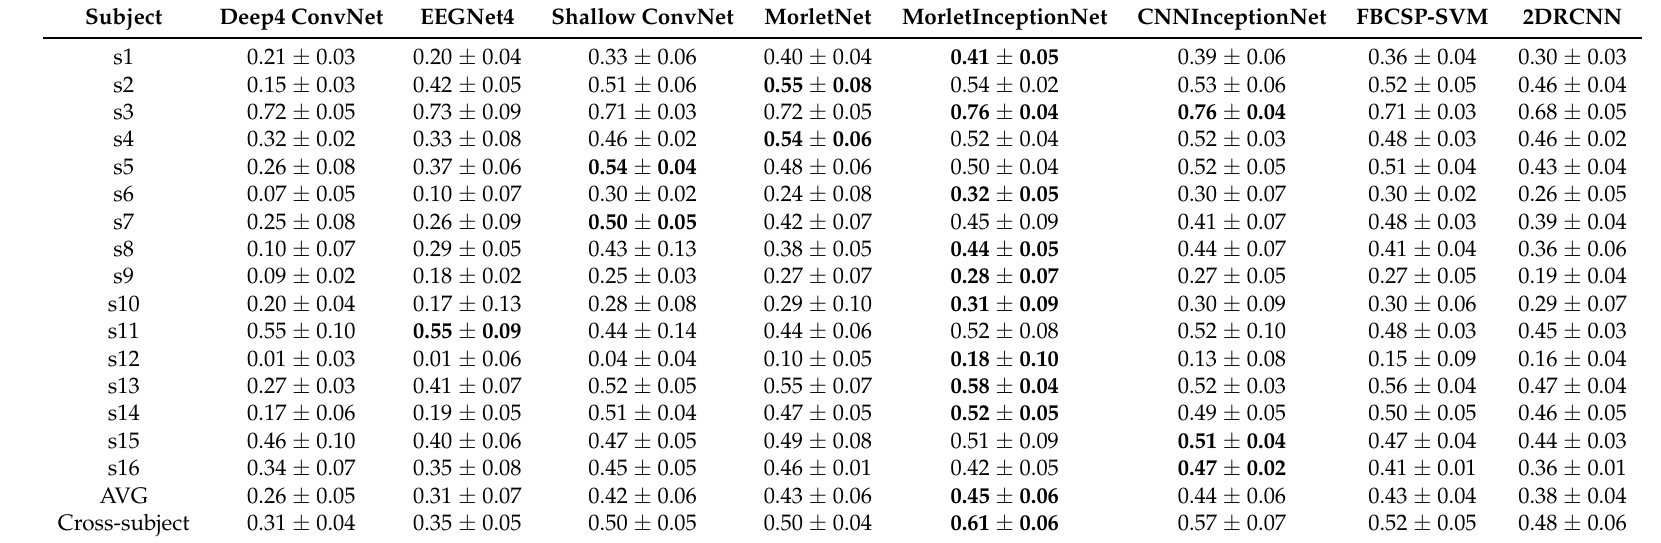
Table 2. Comparison of our method with baseline methods in terms of kappa value for the fatigue dataset of specific subject and cross-subject, best scores are in